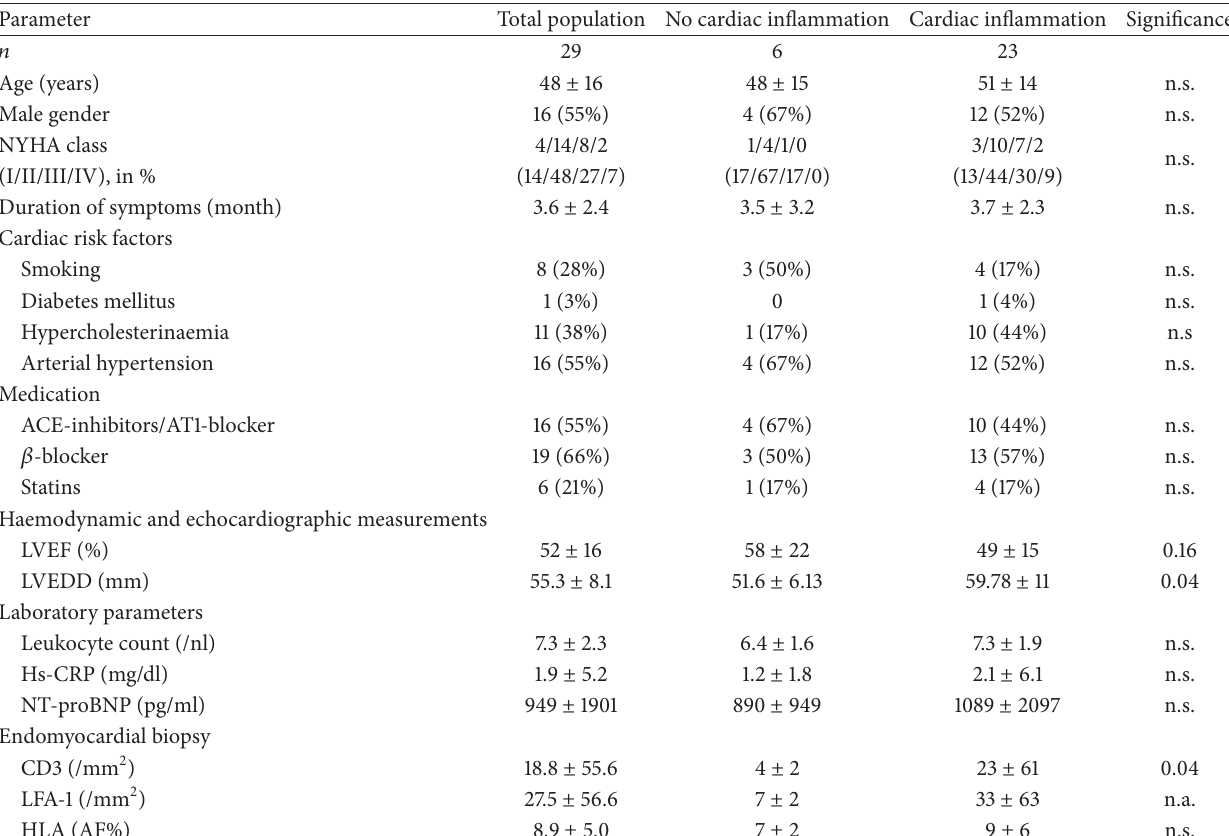
Table 1: Patients’ baseline